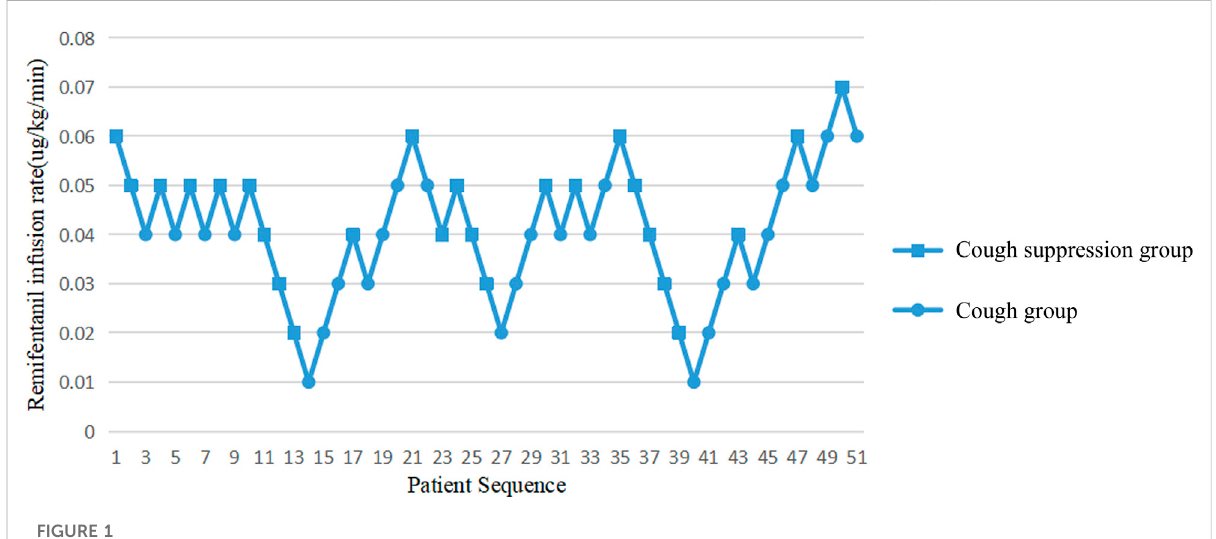
FIGURE 1 Infusion rate of remifentanil and extubation response in